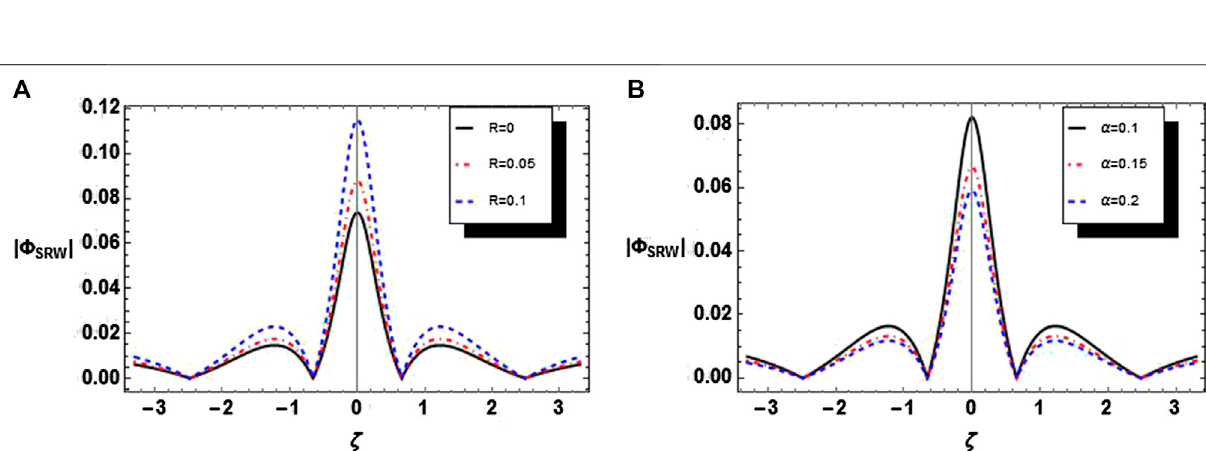
Frontiers in Physics |